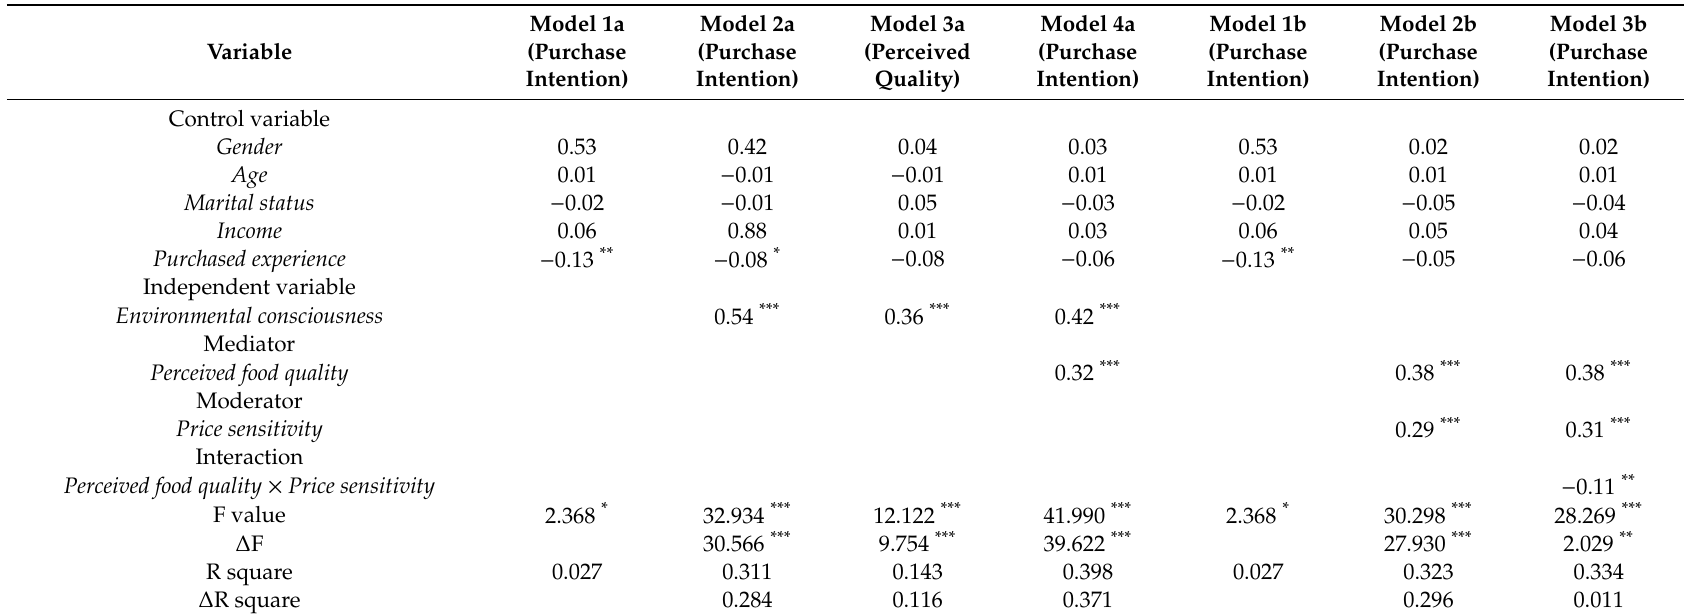
Table 5. Results of the hypothesis